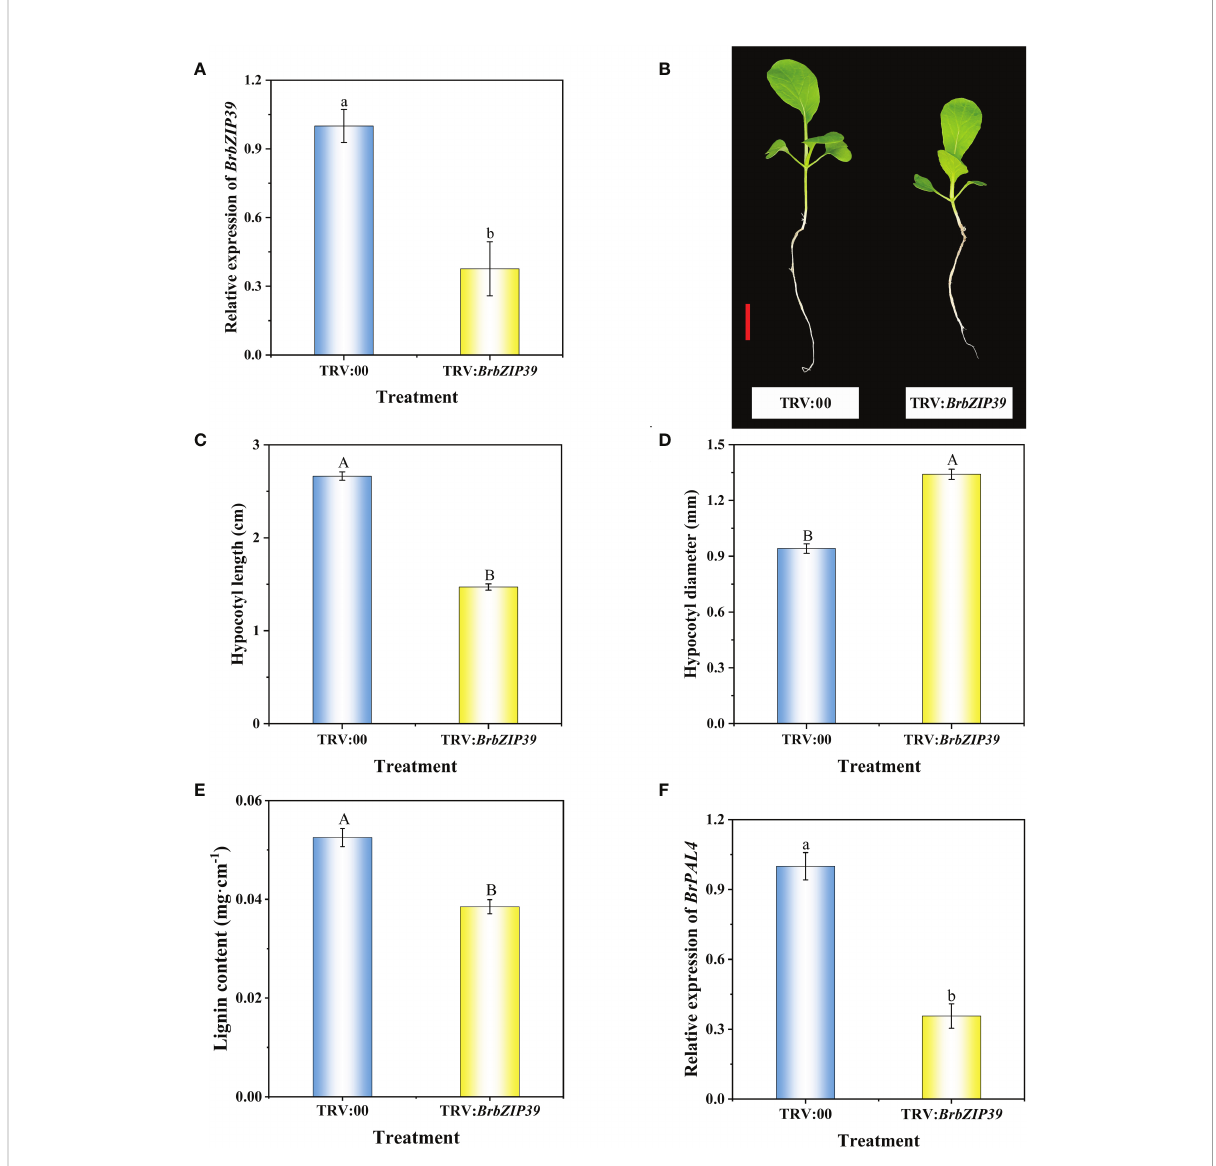
FIGURE 8 Silencing of BrbZIP39 in fl owering Chinese cabbage by virus-induced gene silencing. The phenotype (A) , relative expression of BrbZIP39 (B) , hypocotyl length (C) , hypocotyl diameter (D) , relative expression of BrPAL4 (E) , and lignin content (F) of TRV:00 and TRV : BrbZIP39 plants in fl owering Chinese cabbage. The vertical bars show the standard error of the mean ( n = 6). Red bar, 2 cm. Letters above columns mean signi fi cant difference at P <